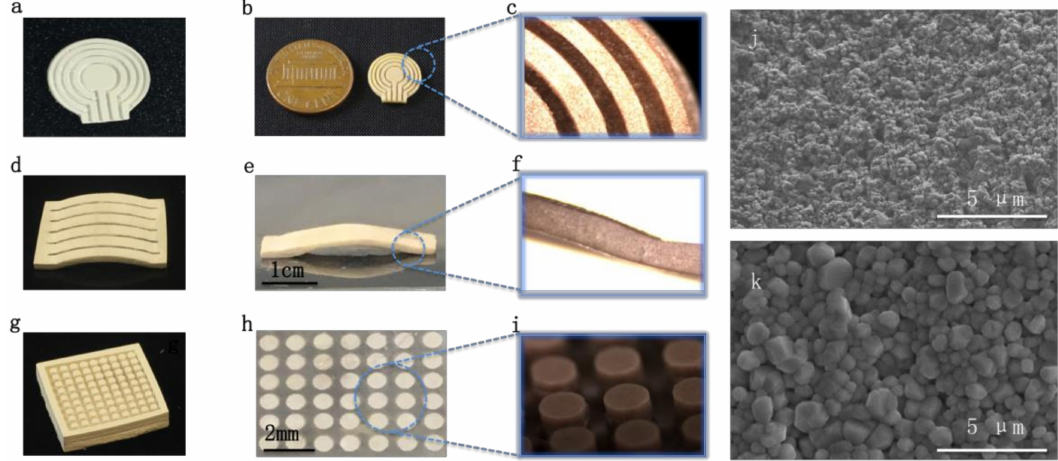
Figure 2. ( a ), ( d ), ( g ) Green-part fabricated by MIP-SL system. ( b ), ( e ), ( h ) Optical images of piezoelectric array after sintering. ( c ), ( f ), ( i ) Details of the array under microscope. ( j ) Scanning electron microscope image of printed sample after debinding process. ( k ) SEM image of printed sample after sintering process. A set of cylindrical samples with 10mm diameter and different thickness (400 µ m, 800 µ m, 1.2 mm, 1.6 mm) were fabricated using the same fabrication process. The bulk cylindrical samples and the printed array with complex geometry were used to characterize the printed piezoelectric ceramics. The